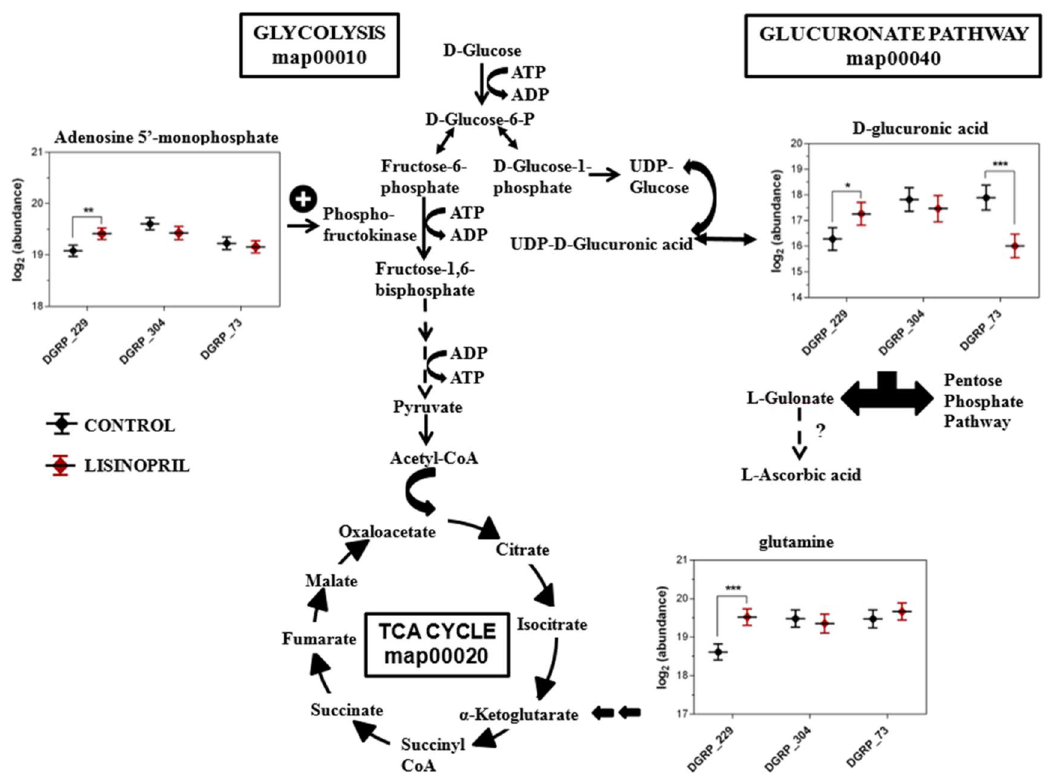
Figure 3. Three metabolites with genotype-specific changes in response to Lisinopril are involved in glycolysis regulation, the glucoronate pathway, and the tricarboxylic acid (TCA) cycle. Data reported on the plots represent the mean log 2 abundance of three replicate samples for each treatment and genotype group. * p < 0.05, ** p < 0.05, *** p < 0.001 after Benjamini and Hochberg’s adjustment for multiple comparisons. Error bars represent the 95% confidence interval. ?: Hypothetical connection in Drosophila melanogaster